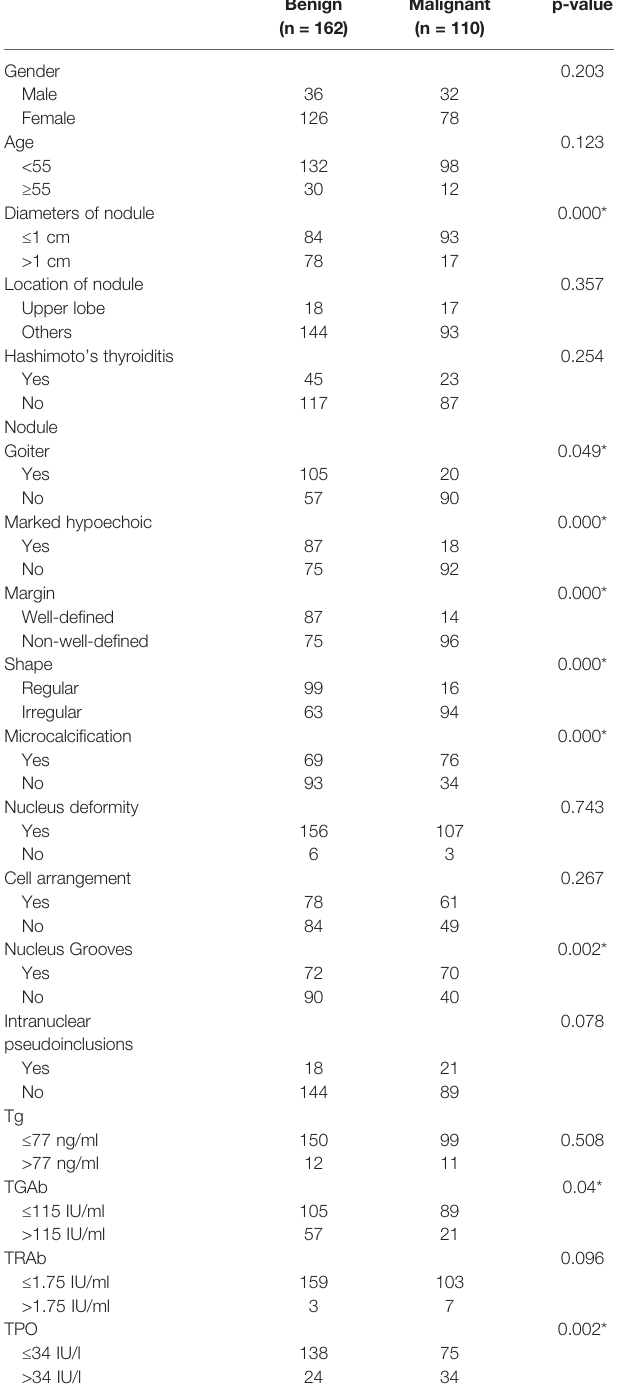
TABLE 2 | Multivariate analysis of the malignant risk factors of thyroid nodules.